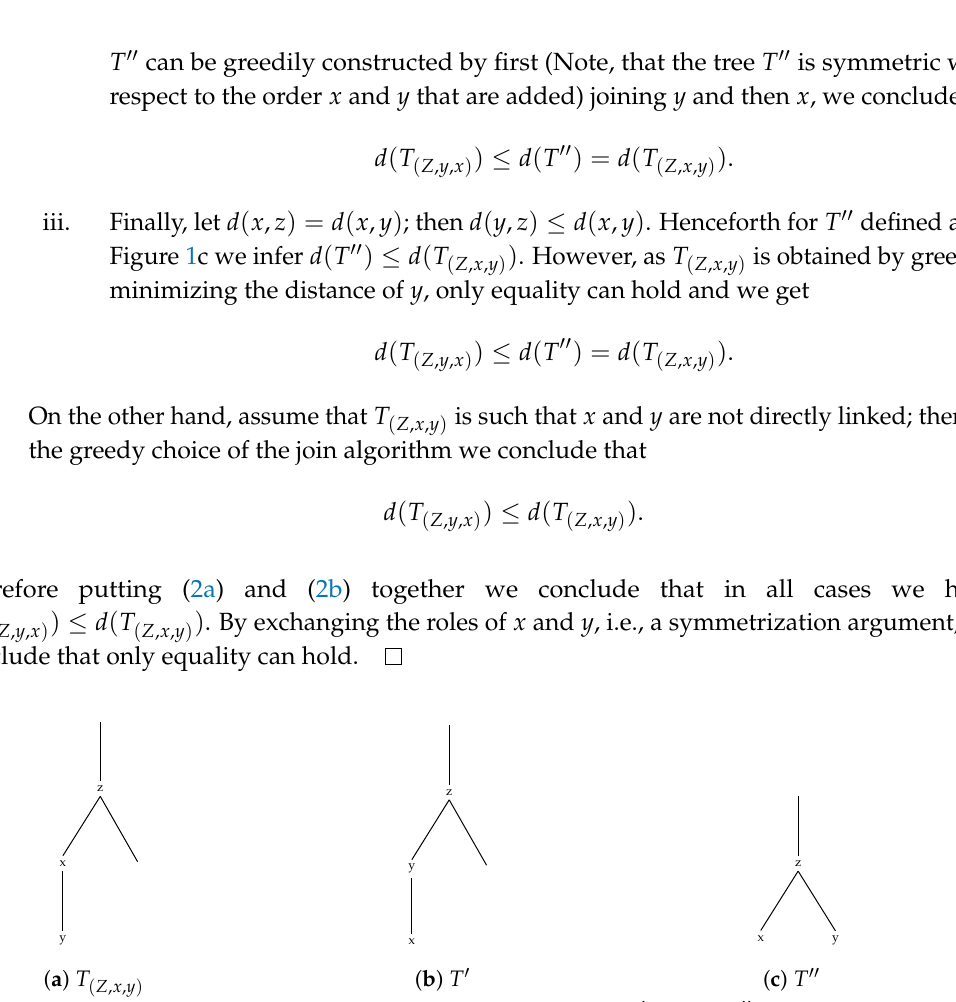
Figure 1. (a) Tree T ( Z , x , y ) with x and y connected; (b) equivalent trees T (cid:48) and (c) T (cid:48)(cid:48) with same distance.